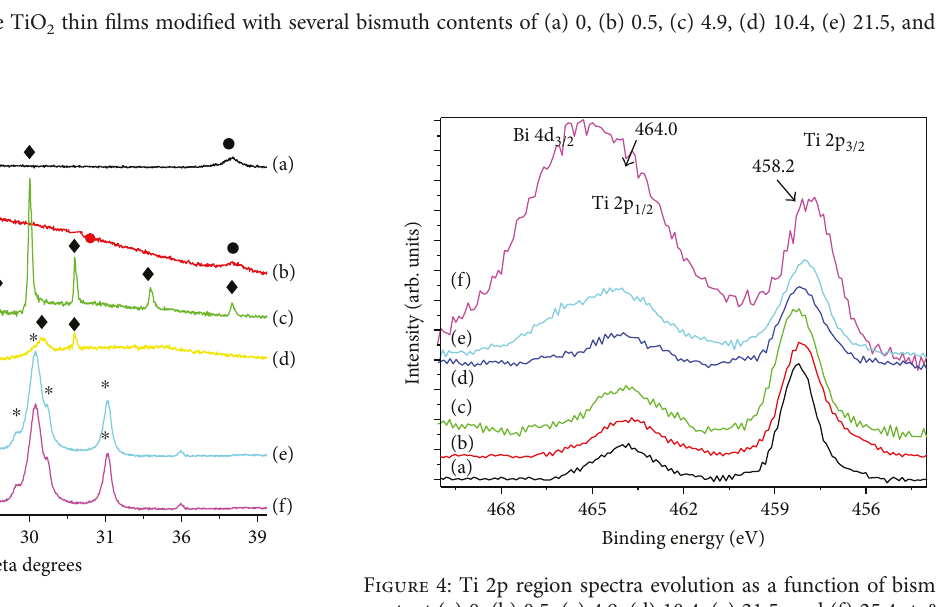
thin fi lms modi fi ed with 2